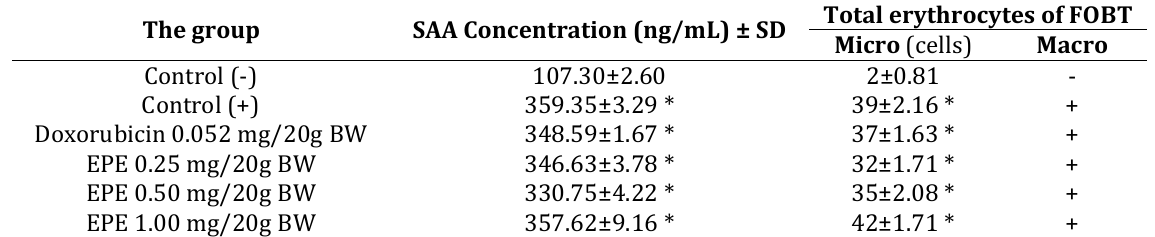
Table I. Results of SAA and FOBT measurements of BALB/c mice for CACmodel. Each mice of all group were sacrificed to conduct serum amyloid α and fecal occult blood test, which is performed four times. SAA samples were obtained from cardiac blood collection and analyze using ELISA assay, while FOBT samples were obtained by swab paper kit into rectum each mice. Calculation of total erythrocytes based on the number of cells erythrocytes that change color to green.